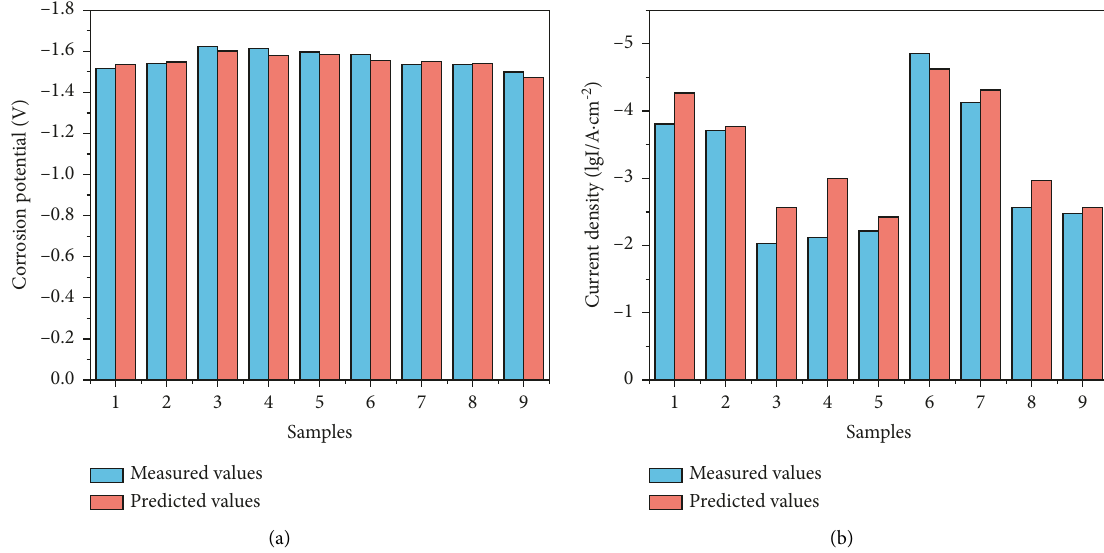
Figure 4: Comparisons of experimental measurements with predicted values using machine learning models: (a) comparison of corrosion potential results and (b) comparison of corrosion current results. Nine validation set samples were